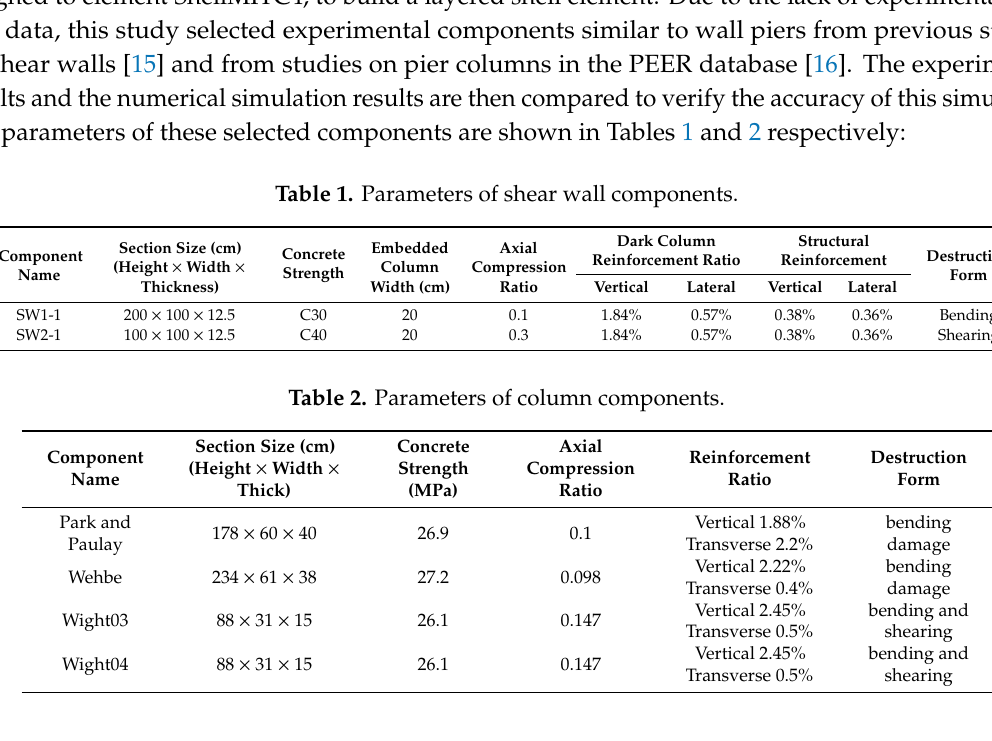
Table 1. Parameters of shear wall components.